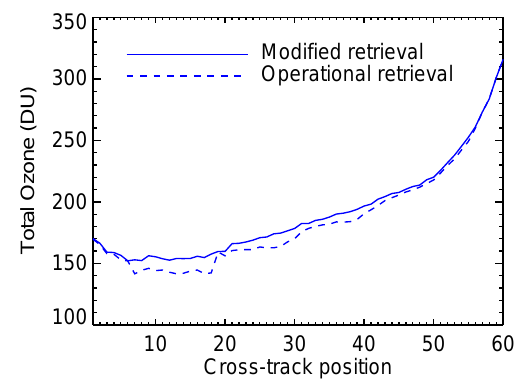
Fig. 13. Total column ozone retrieved with OMI scene pressures (modified) and those retrieved with the no-cloud assumption over snow and ice (operational) along OMI scan line 400 as a function of OMI cross-track position.